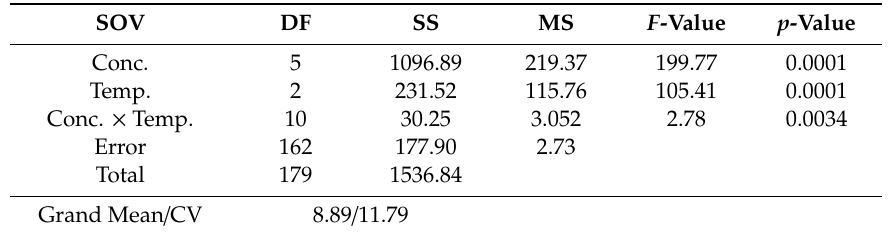
Table A10. Nymphal development time of overall ( M. persicae ) in relation to PeBL1 elicitor and temperature.